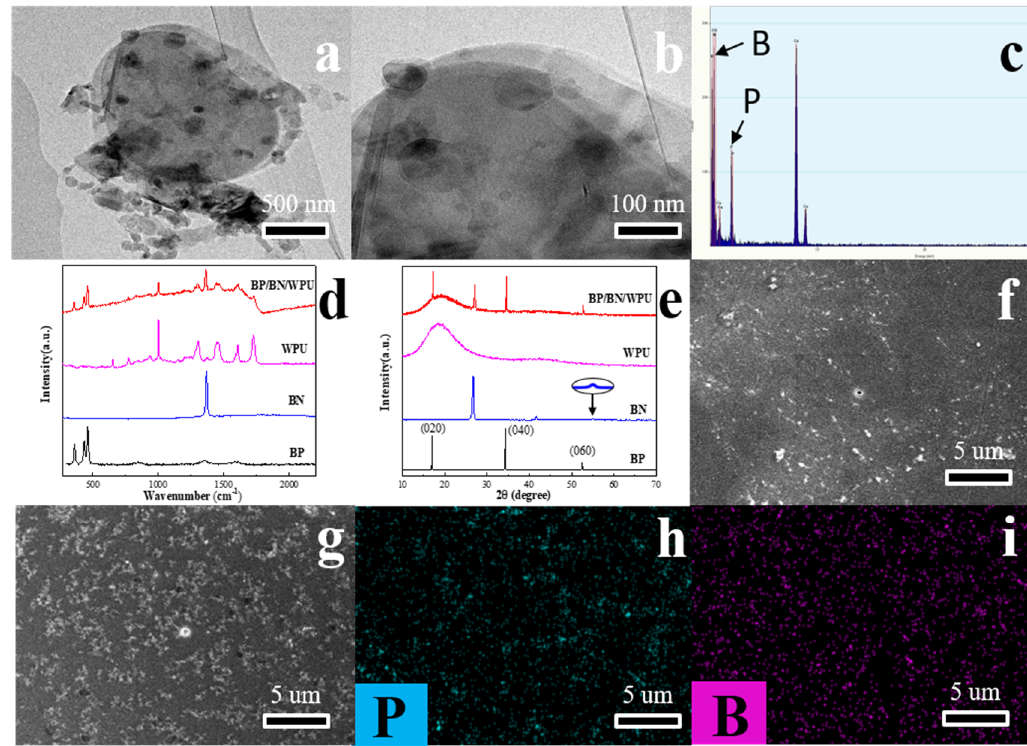
Figure 1. ( a , b ) TEM image of BP / BN nanosheets; ( c ) The EDS of BP / BN nanosheets; ( d ) Raman spectra of BP, BN, WPU and BP / BN / WPU; ( e ) XRD spectra of BP, BN, WPU and BP / BN / WPU; ( f ) and ( g ) SEM image of WPU and BP / BN / WPU; ( h ) phosphorus mapping in BP / BN / WPU and ( i ) boron mapping in BP / BN / WPU.